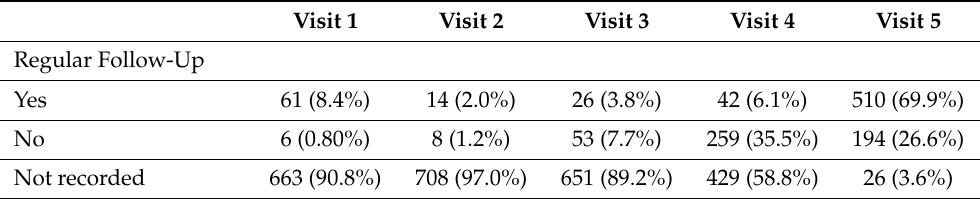
Table 2. Details of regular follow-up and clinic attendance between December 2019 and November 2021 (n = 730). Visit 1 Visit 2 Visit 3 Visit 4 Visit 5 Regular Follow-Up